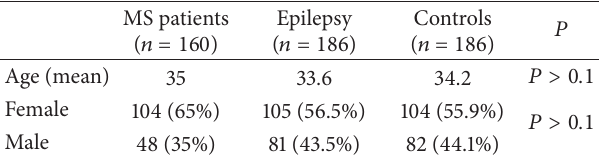
Table 1: Patients with epilepsy and multiple sclerosis versus controls characteristics.